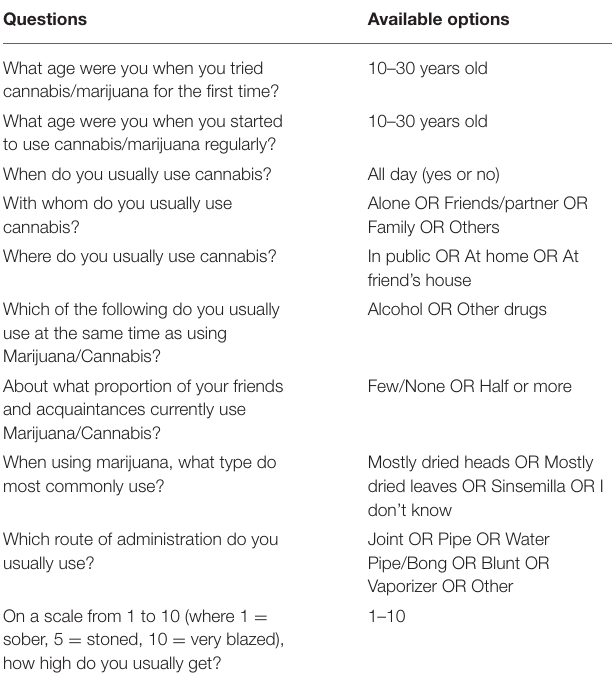
TABLE 1 | Items asked to measure levels of cannabis